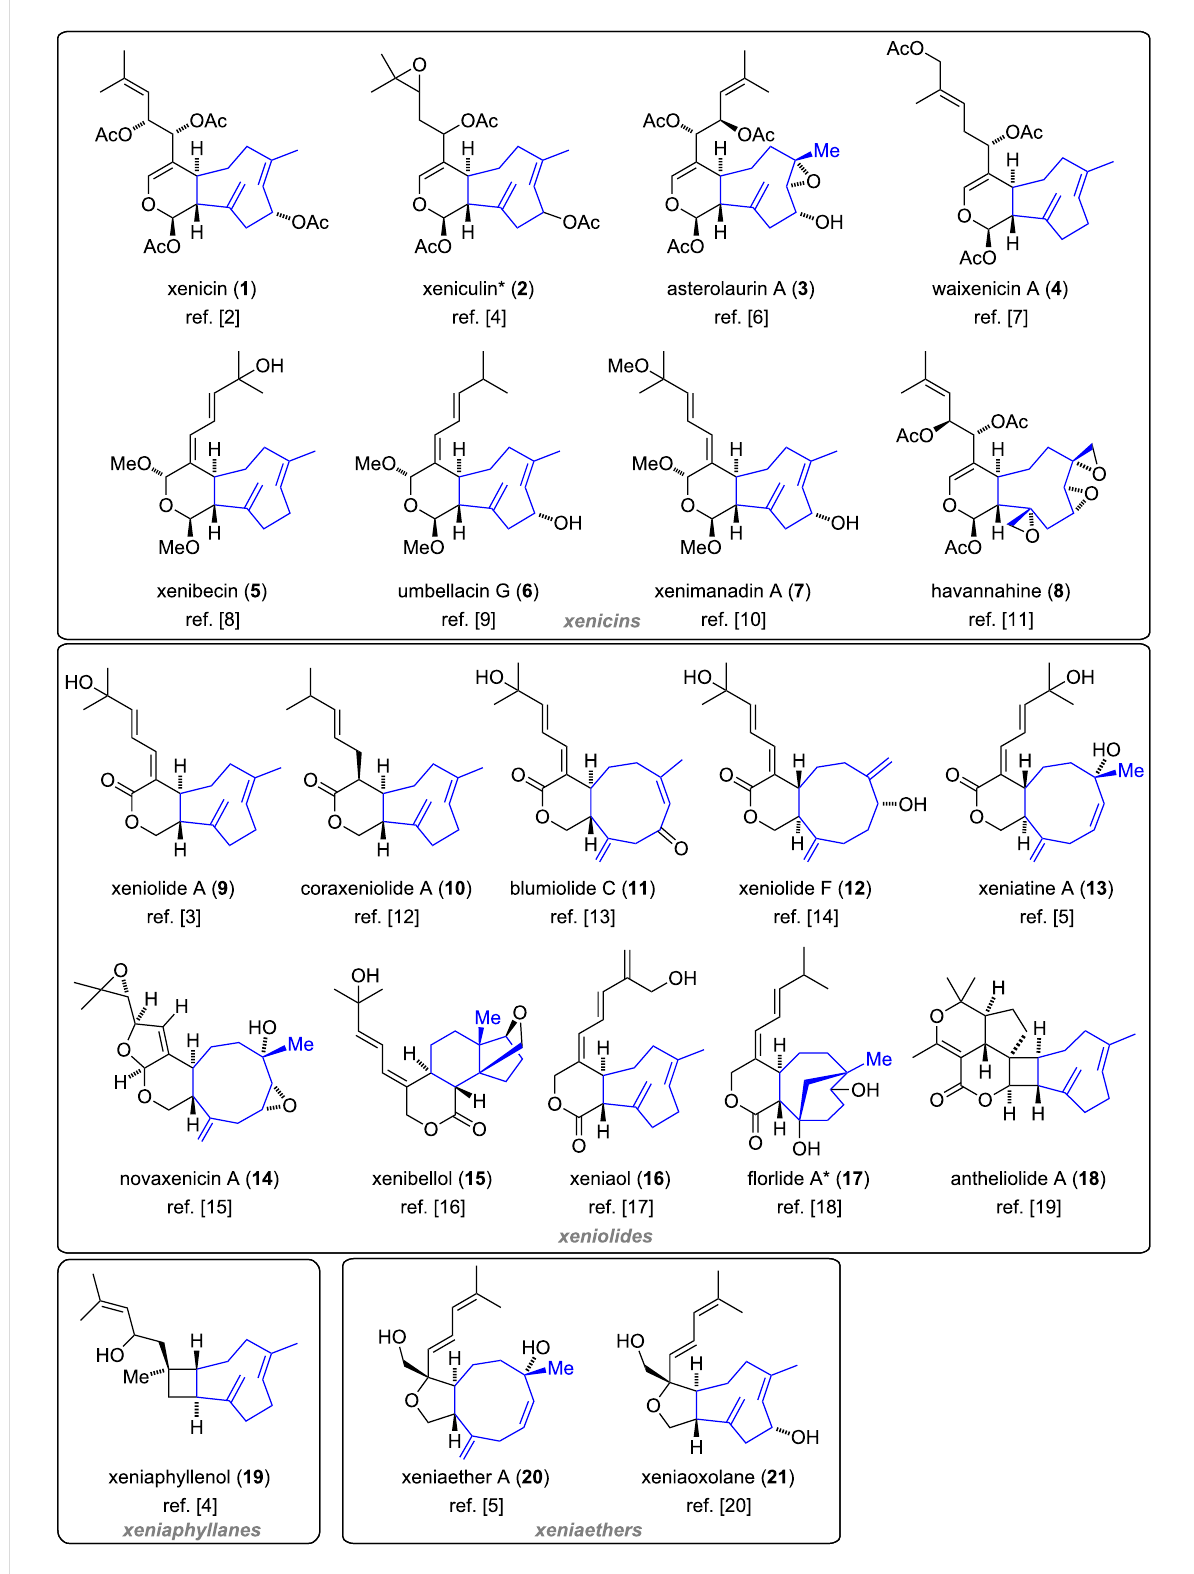
Figure 2: Overview of selected Xenia diterpenoids according to the four subclasses [2-20]. The nine-membered carbocyclic rings are highlighted in blue. *Stereochemistry not